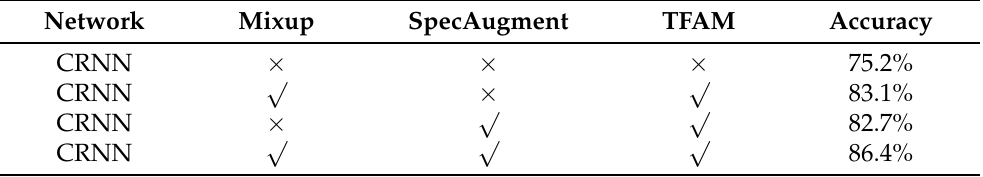
Table 7. Classification accuracy of whether to use mixup or